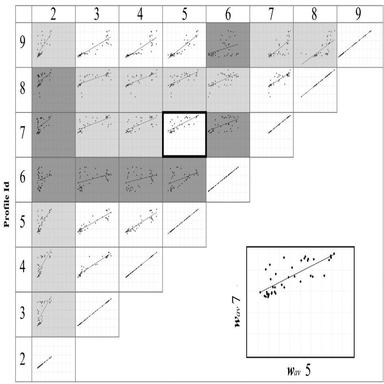
Pearson correlation coefficient R2 between readings of the PG3 water content profiles. Dark grey, values lower than 0.4; light grey, values between 0.4 and 0.6; white, values higher than 0.6.